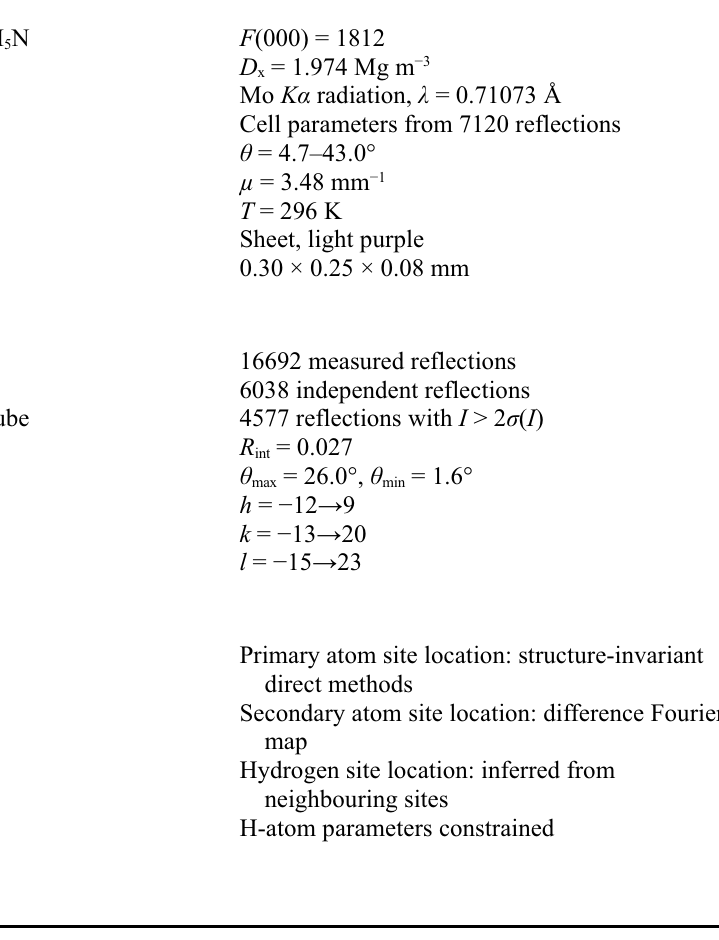
Figure 1 The molecular structure of (I), with atom labels and 30% probability displacement ellipsoids for non-H atoms. Atoms labelled with an A belong to the symmetry-related ligand ATPA with symmetry code [A = - x + 3/2, - y , z + 1/2)]. catena -Poly[[[aquatripyridinecobalt(II)]- µ -5-amino-2,4,6- triiodoisophthalato- κ 2 O 1 :O 3 ] pyridine solvate] Crystal